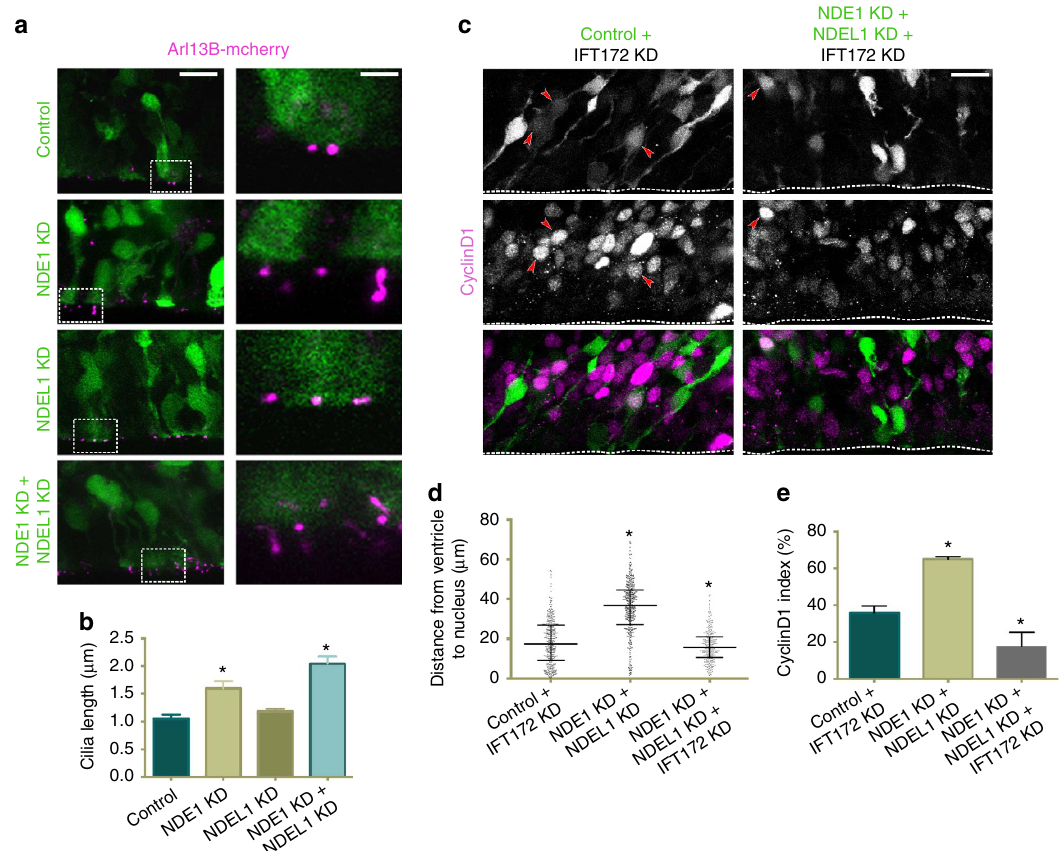
Figure 4 | The G1-to-S arrest of radial glia progenitors in the NDE1/NDEL1 double knockdowns disrupts the regulation of primary cilia length. E16 rat embryonic brains were electroporated with the ciliary membrane marker Arl13B and shRNAs to the various conditions described below. All analyses were done at E19. ( a , b ) NDE1 knockdown resulted in a significant increase in primary cilia length among electroporated radial glia progenitors (RGPs), though the NDE1/NDEL1 knockdown caused an even greater doubling of primary cilia length. NDEL1 knockdown resulted in no change from control RGP cilia length. ( c – e ) Inhibition of primary cilia assembly by knockdown of the intraflagellar transport protein IFT172 rescued the CyclinD1 accumulation seen in the NDE1/NDEL1 double knockdown ( e ). The distribution of apical process lengths of the NDE1/NDEL1/IFT172 triple knockdown more closely mirrored the NDE1 knockdown alone (Fig. 2c). Arrowheads mark electroporated RGP cells positive for CyclinD1. Dashed line indicates ventricle surface. Data are presented as mean ± s.e.m. Unpaired t -tests used to compare conditions in b and e , Kolmogorov–Smirnov test used for non-parametric distributions in d , * P o 0.05, n ¼ 3 embryonic brains from different mothers. Scale bar, 10 m m in a and c , and 2.5 m m in insert panels for a . Also see Supplementary Figs 4 and